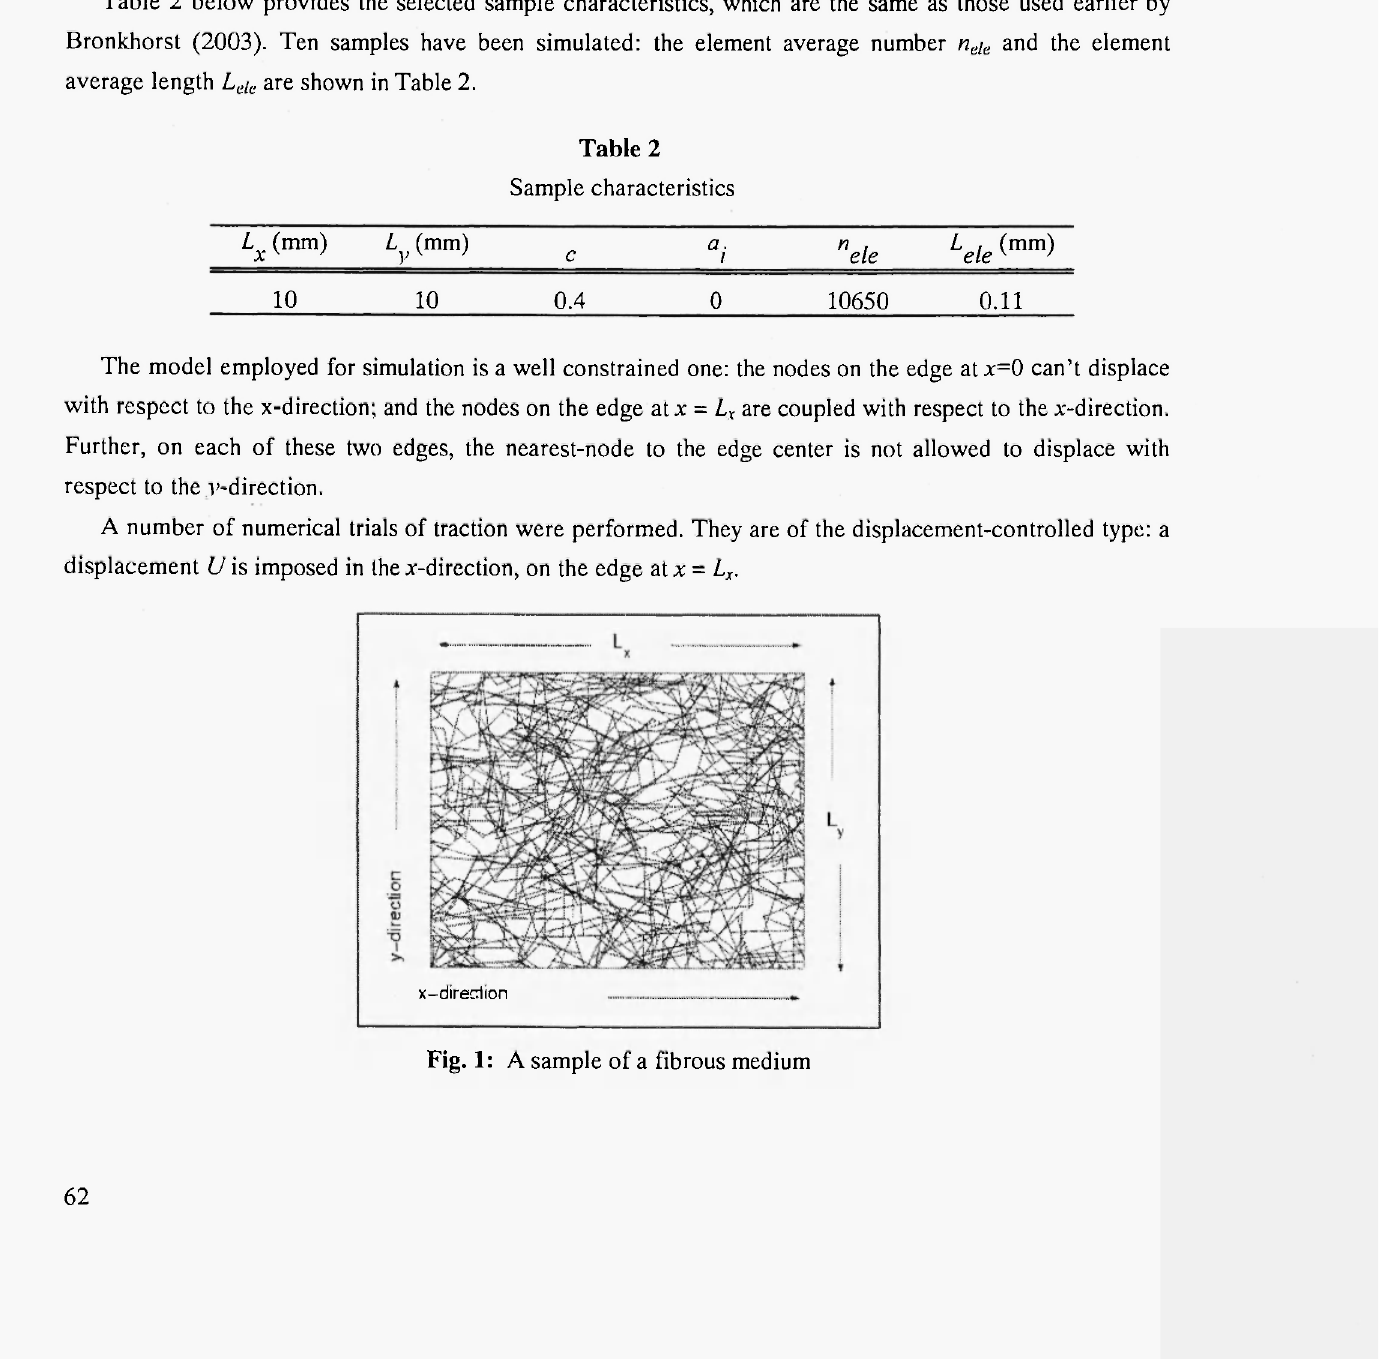
Fig. 1: A sample of a fibrous